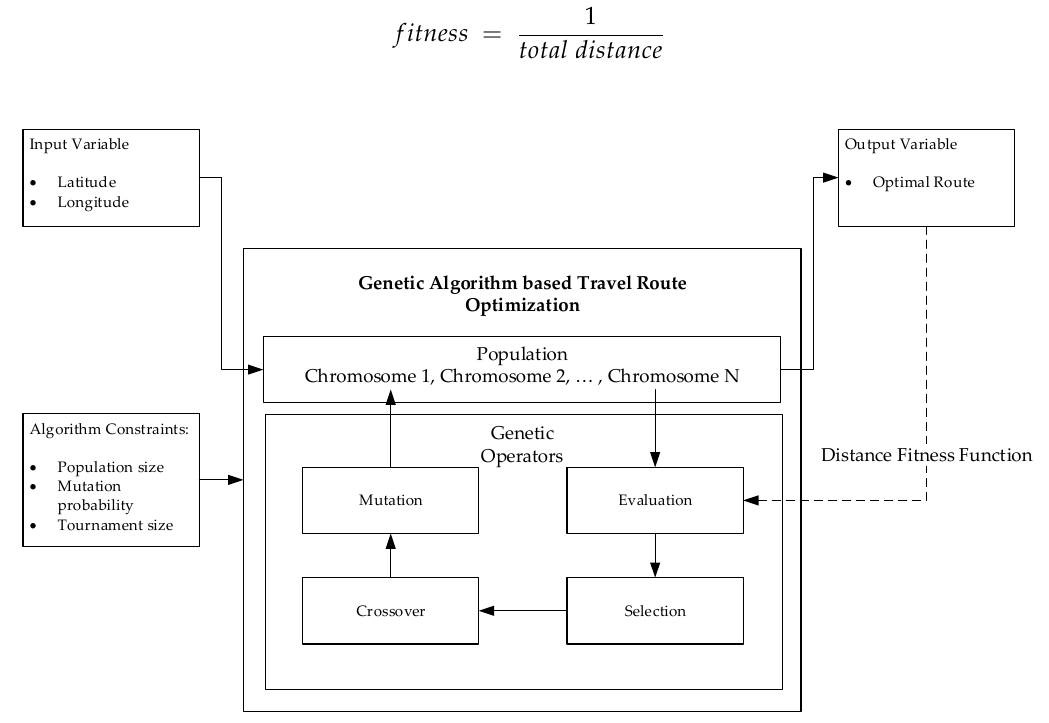
Figure 6. The process flow of genetic algorithm ‐ based travel route optimization.